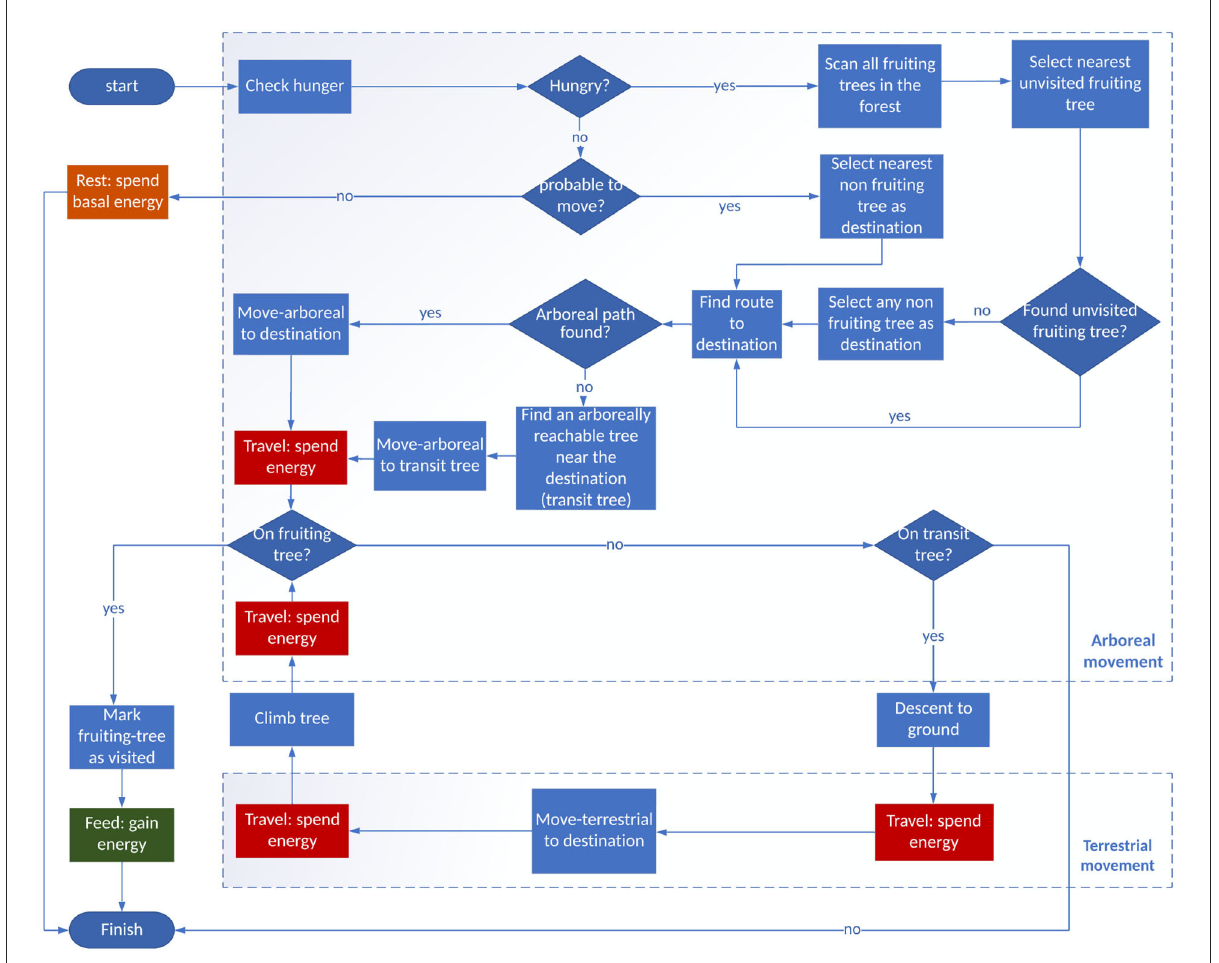
FIGURE2 Movement procedure flowchart showing the steps performed by the orangutan in order to fulfill the objective of maintaining its energy balance. Orangutans perform activities involving energy expenditure not only when traveling (spend movement energy), but also while resting (spend basal energy). Energy intake increases when the orangutan is performing feeding activities. Orangutan travels through a tree network to perform activities, which is decided by the state of hunger (satiation level). When hungry, orangutan searches the nearest fruiting tree as a destination. The orangutan then searches for an arboreal route (as a preference) through the tree network to reach the destination from its initial position. If an arboreal route is available (there is a connected path within the network to reach the destination), the orangutan performs a fully arboreal movement. Orangutan switches to terrestrial movement if part or the entire route to the destination lacks arboreal